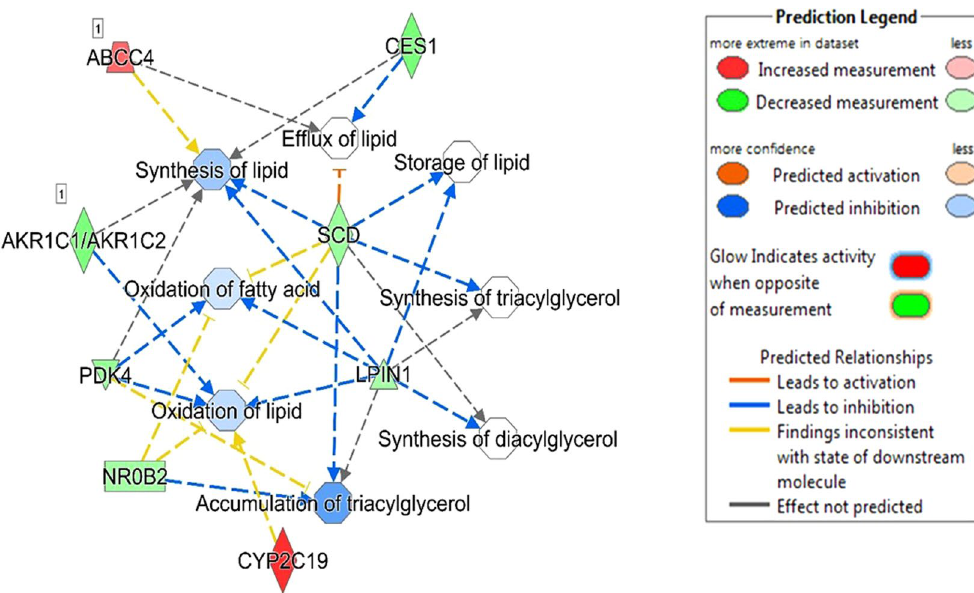
Figure 4. Metabolic process regulatory gene network showing differentially expressed (DE) genes involved in the different lipid metabolic processes and their predicted activation or deactivation levels in Charolais low-RFI